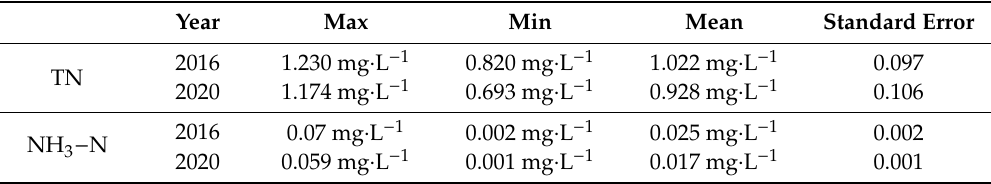
Table 1. Statistics of the measured results.